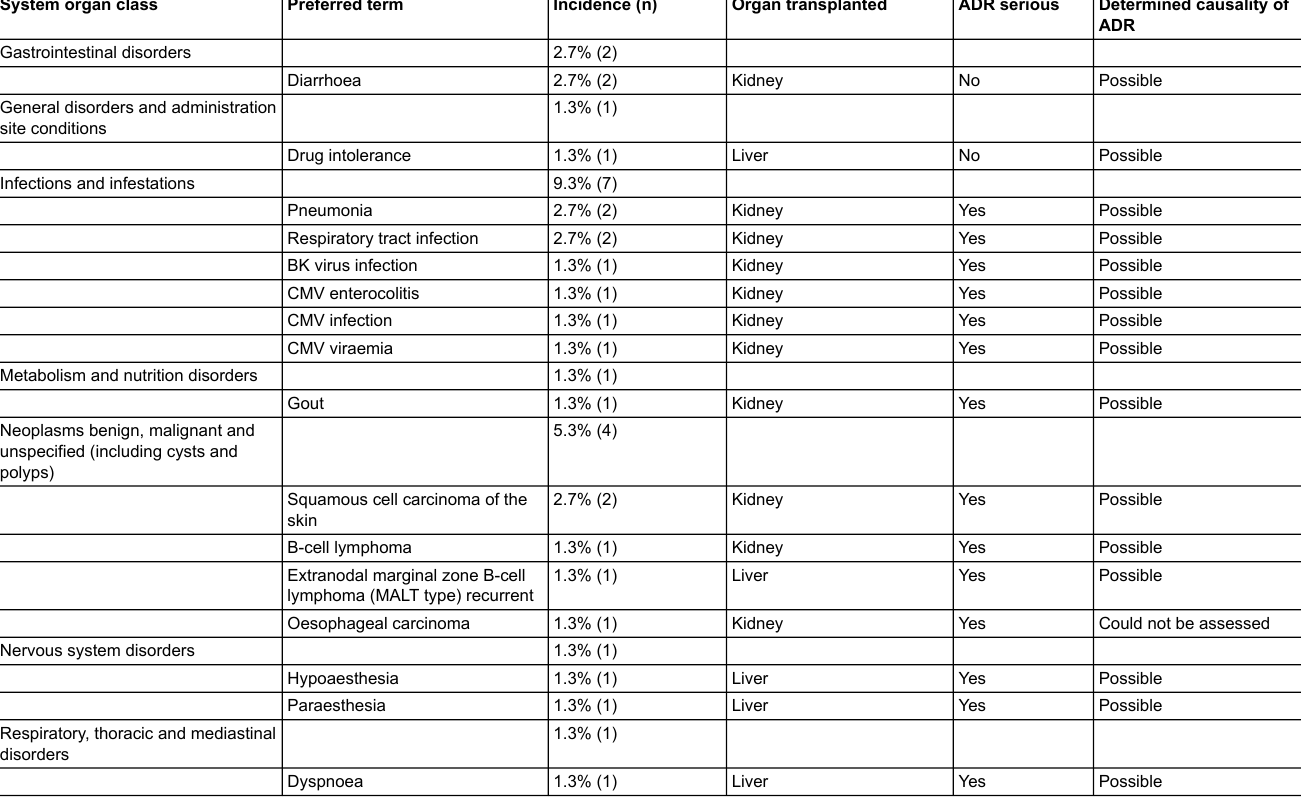
Table 5: ADRs grouped by system organ class and preferred term (safety analysis set). System organ